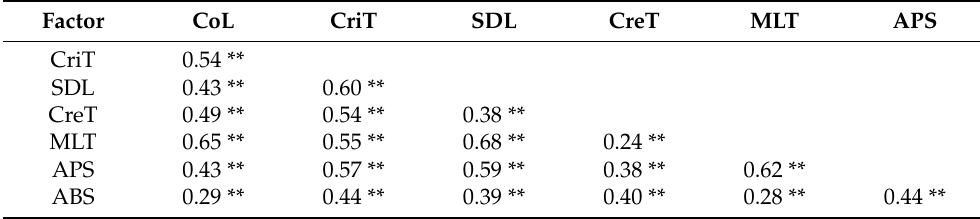
Table 2. Correlation Matrix of the 21